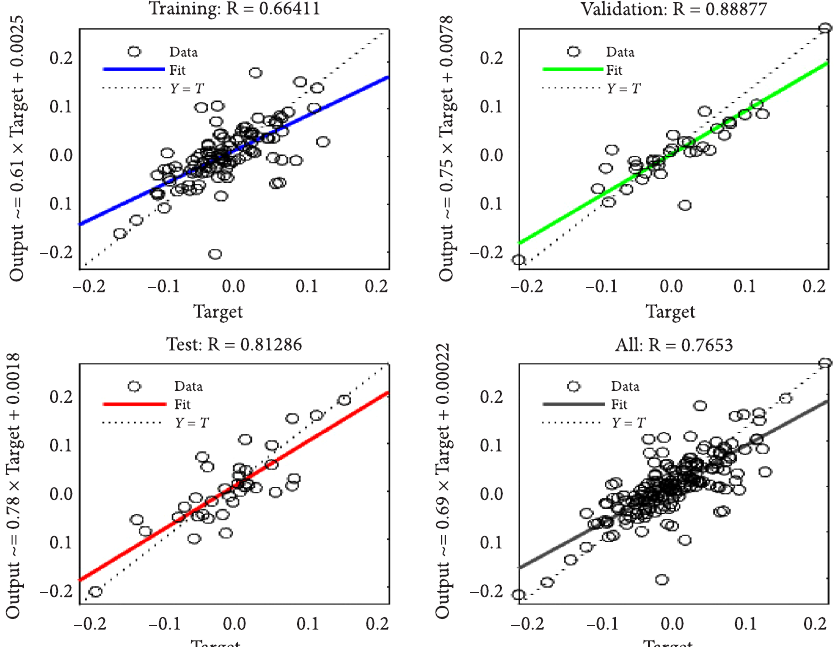
Figure 3. FF5F based Regression Analysis for Low Beta